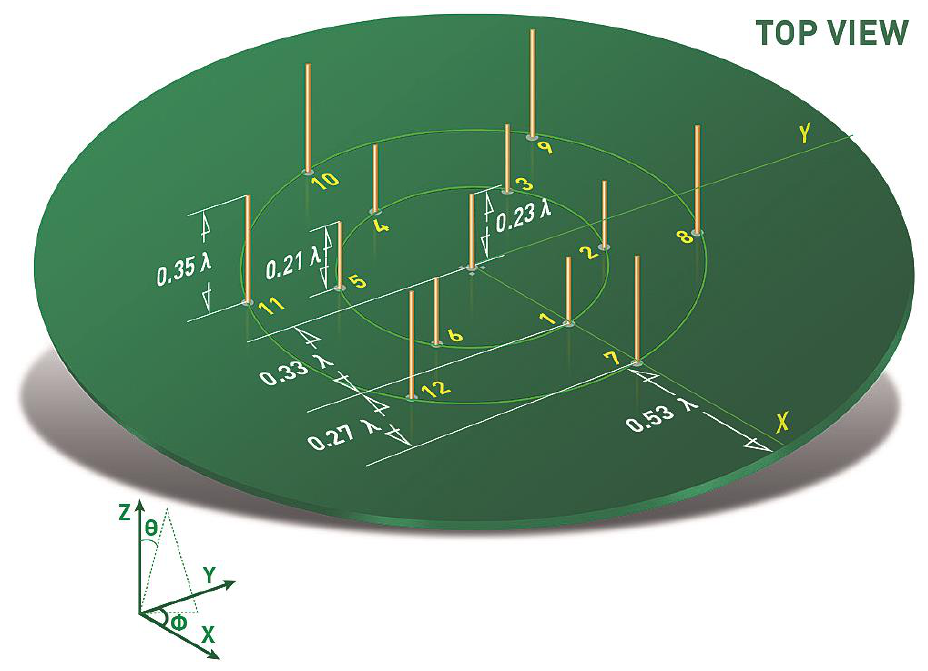
Figure 1. Two-row ESPAR antenna model.